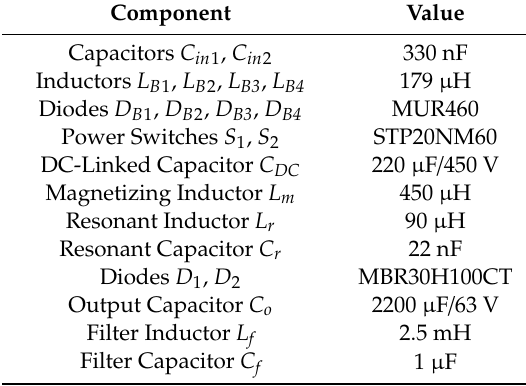
Table 2. Key components utilized in the presented LED streetlight driver.